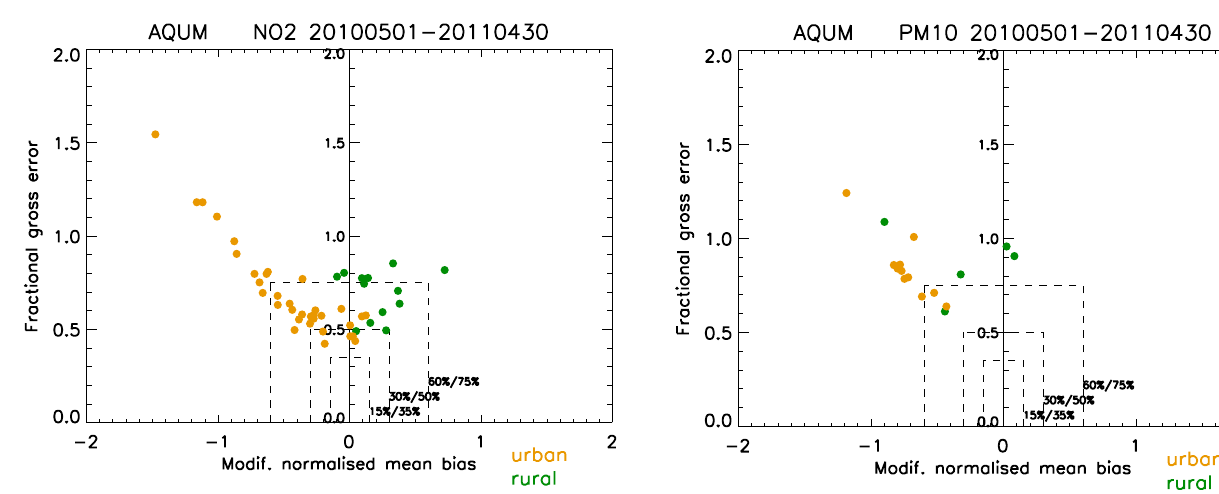
Fig. 4. Soccer plot for PM 10 for the period 1 May 2010 to 30 April 2011. Urban background and suburban sites are shown in orange, while remote and rural sites are given in